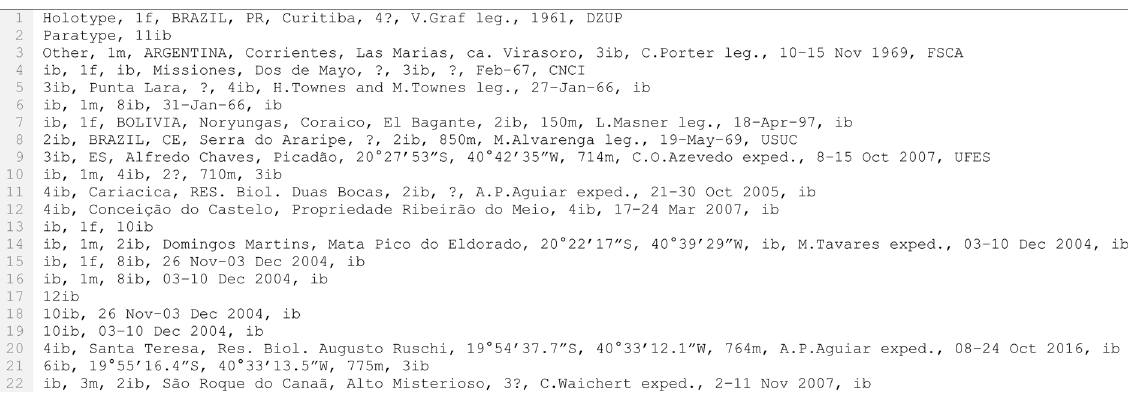
Fig. 5. Data from the spreadsheet in Fig. 4, excluding header and the column scientificName, copied and pasted into a text editor; resulting tabs (cells) replaced with comma. Sequences of “ib” and “?” in each row were grouped together with a preceding number (e.g., “11ib” in row 2) that indicates the total of subsequent repeats. Each row represents a unique collecting event. The final text generated from this file is shown in Table 2.